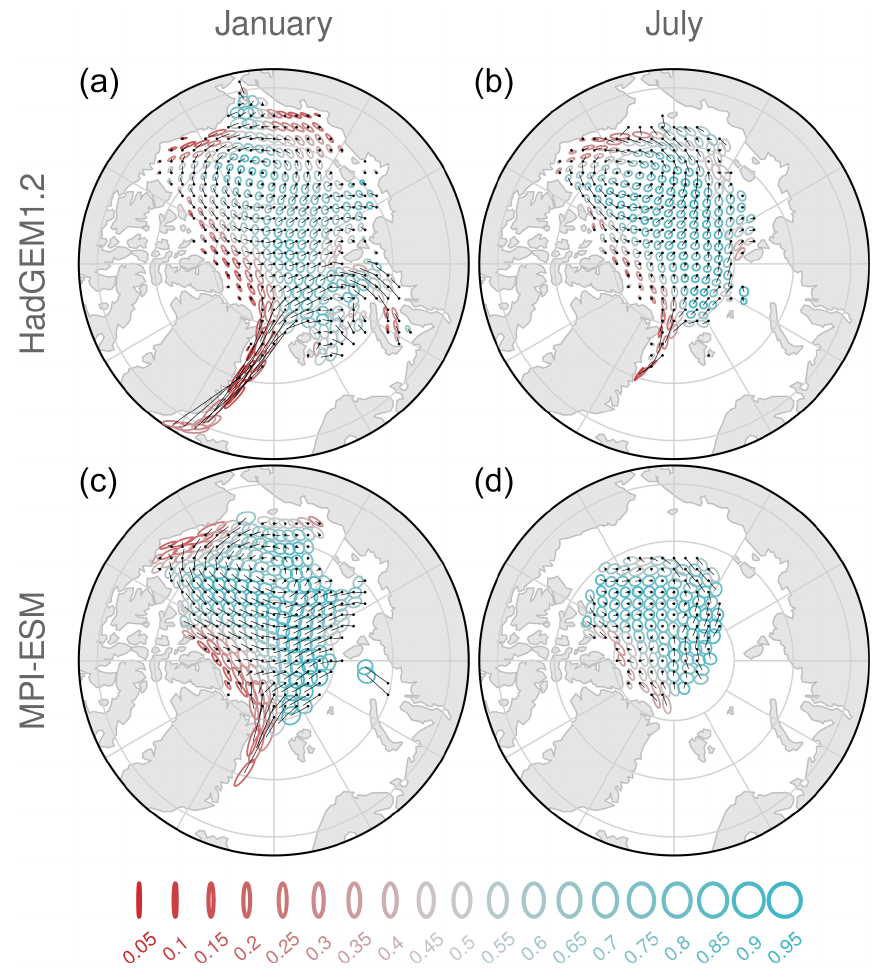
Figure 5. The same as Fig. 4 but for the models HadGEM1.2 and MPI-ESM.